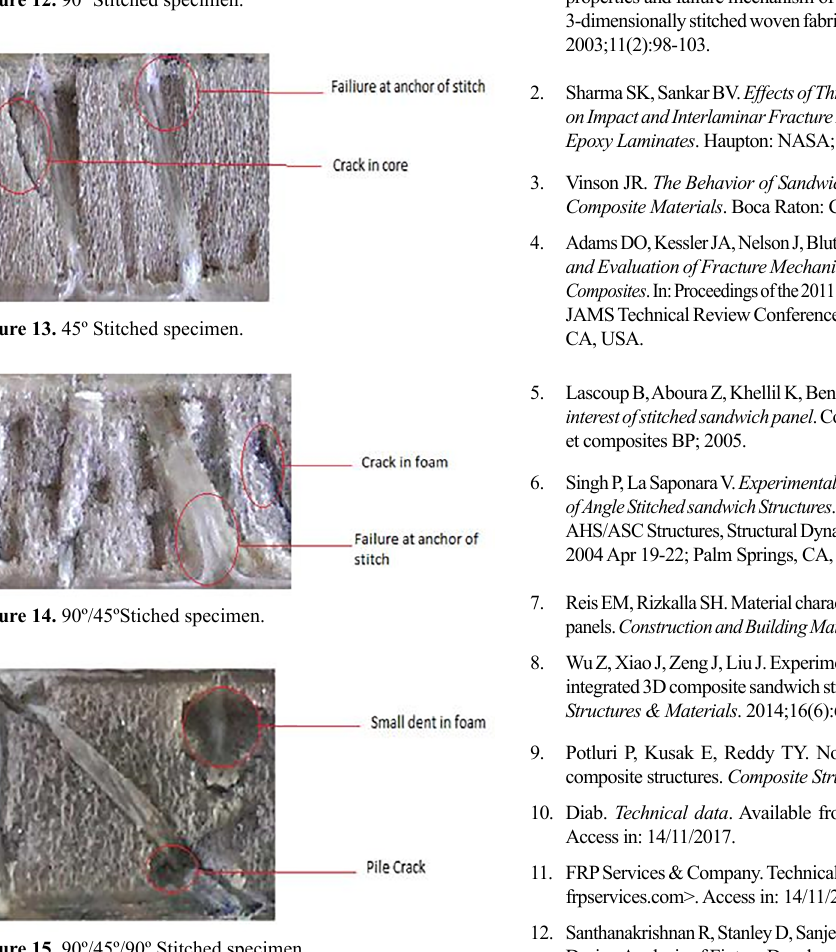
Figure 15. 90º/45º/90º Stitched